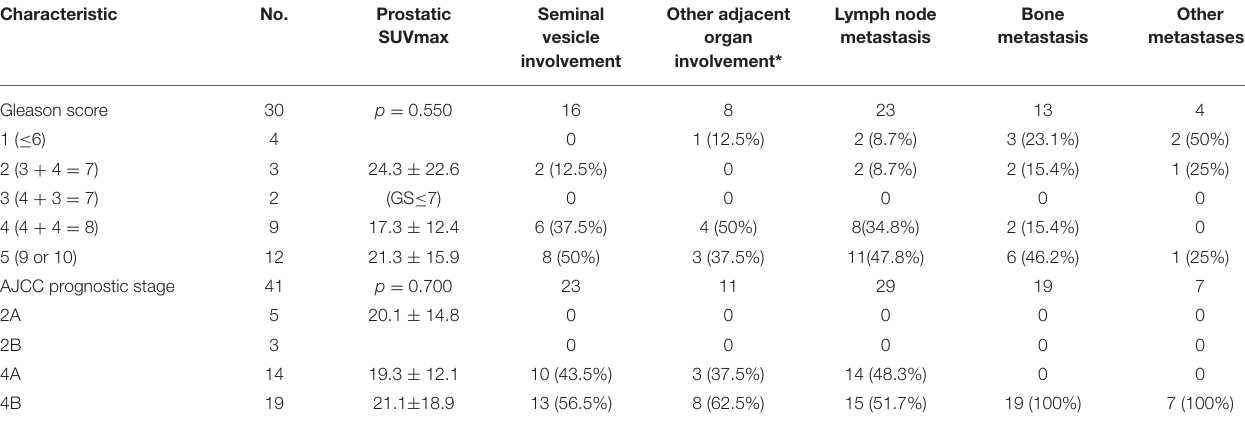
TABLE 2 | Clinical and imaging characteristics in patients with prostate cancer. Characteristic No. Prostatic